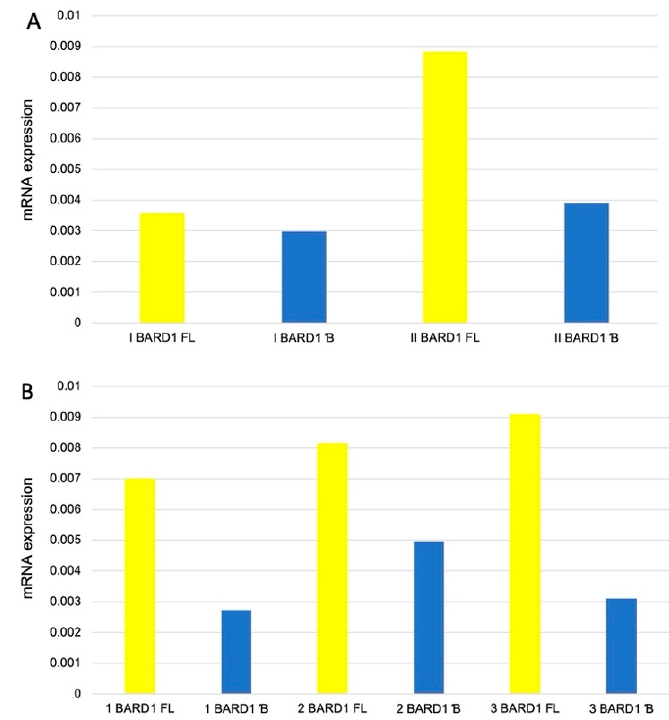
Figure 3. RNA BARD1 isoforms relative expression of neuroblastoma cases. Neuroblastoma patients were divided into two groups based on the INSS stage ( A ) of the disease and Mitosis-karyorrhexis index (MKI) ( B ). Expression BARD1 FL and β results were presented for each group. The results are depicted as